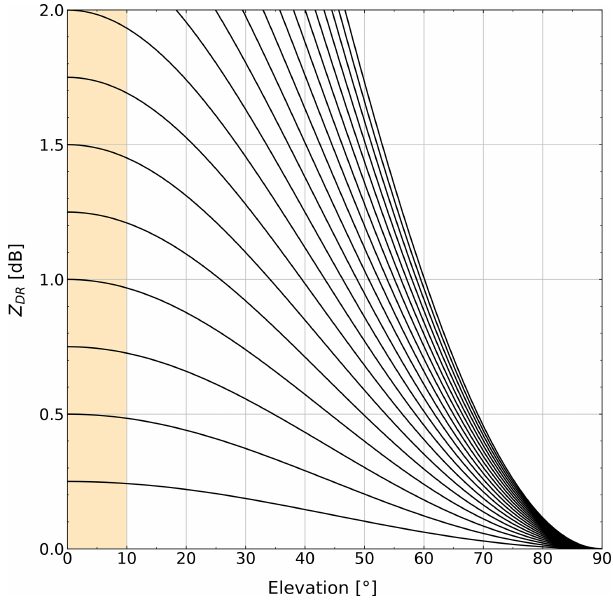
Figure 3. Theoretical dependencies of Z DR at different elevation angles. Highlighted area shows the small variation in Z DR for ele- vation angles below 10 ◦